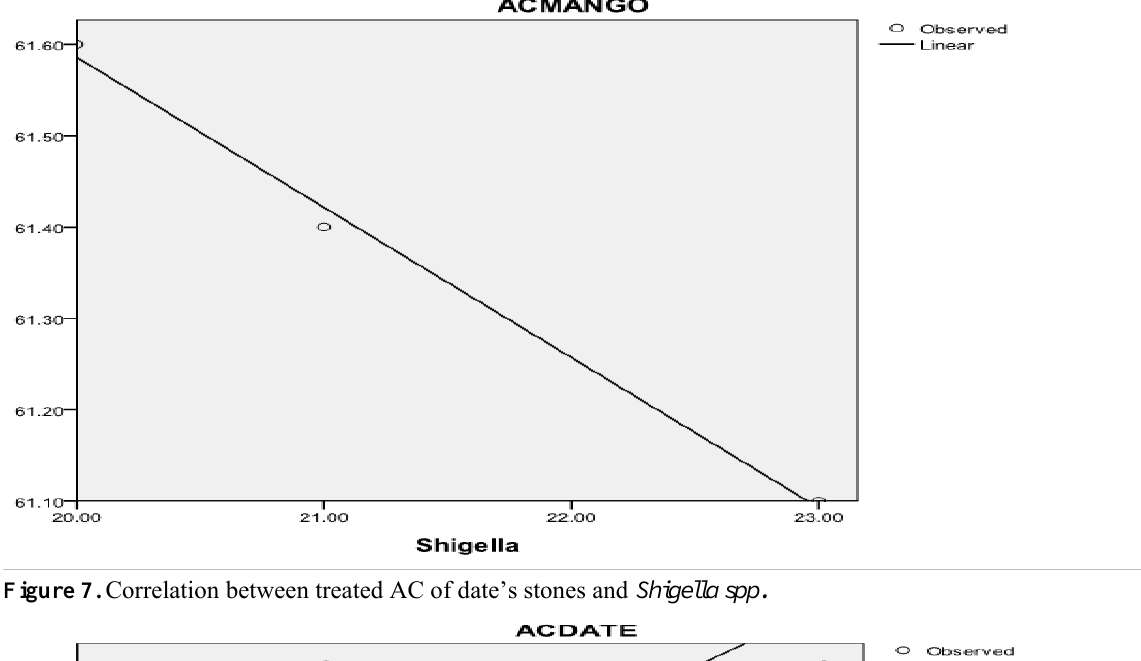
Figure 6. Correlation between treated AC of mango seeds and Shigella spp.